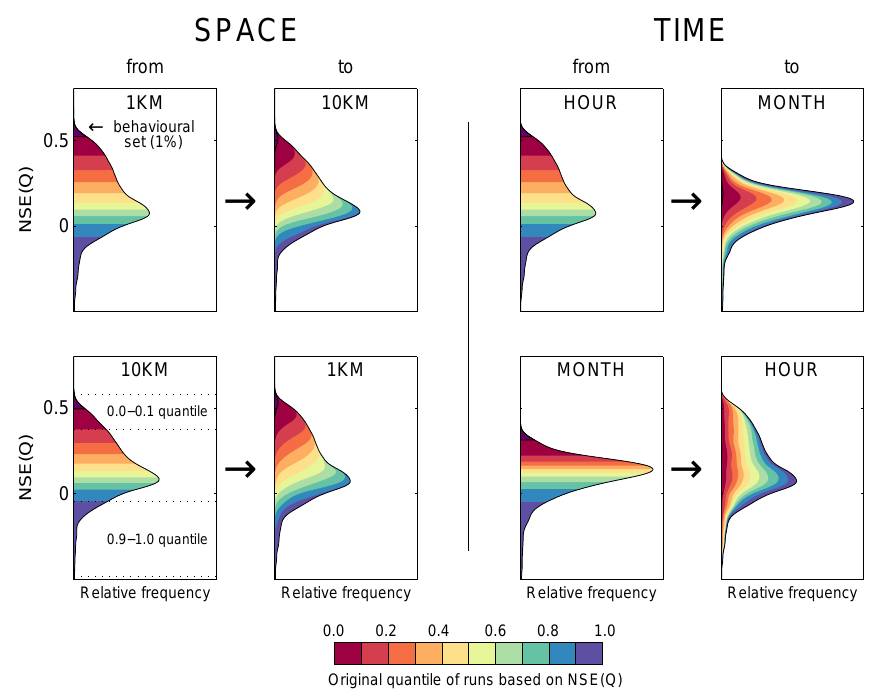
Figure 12. Impact of parameter transfer on model performance. The panels show the distribution of the NSE( Q ) fitted with a kernel density for 3150 runs. On the left-hand side of the arrow the red area represents the best 10% of the runs, each colour interval increasing with 10% to the full data set (100%, purple). The selected behavioural runs are indicated separately with a black line (best 1%). The panel on the right-hand side of the arrow shows the distribution of the model performance for the coloured selections when evaluated at another spatial (left panels) or temporal (right panels) resolution. When the direction of the colours changes from the left panel to the right panel, this implies a low parameter transferability. The data for the first two columns are based on hourly discharges; the data for the second two columns are based on the 1km × 1km